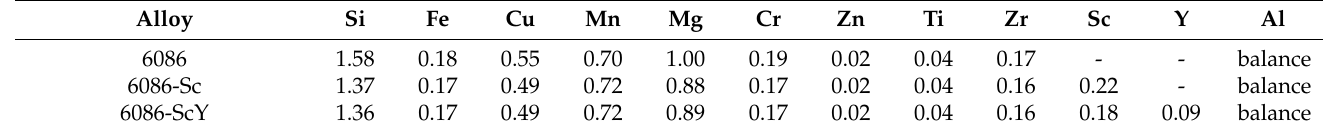
Table 1. The chemical compositions of the investigated alloys in wt.% as determined using AES-ICP (Atomic Emission Spectroscopy—Inductively Coupled Plasma, Agilent 5800 VDV (Vertical Dual View), Agilent Technologies Inc., Santa Clara, CA,